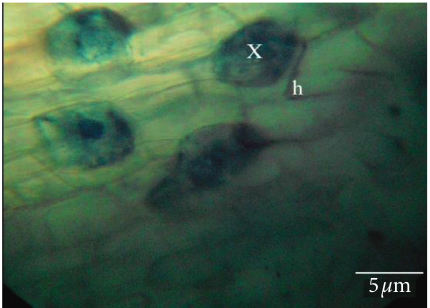
Figure 2: Vanilla root tissue inoculated by BNR: (x) peloton and (h) internal hyphae, under binocular microscope (50x